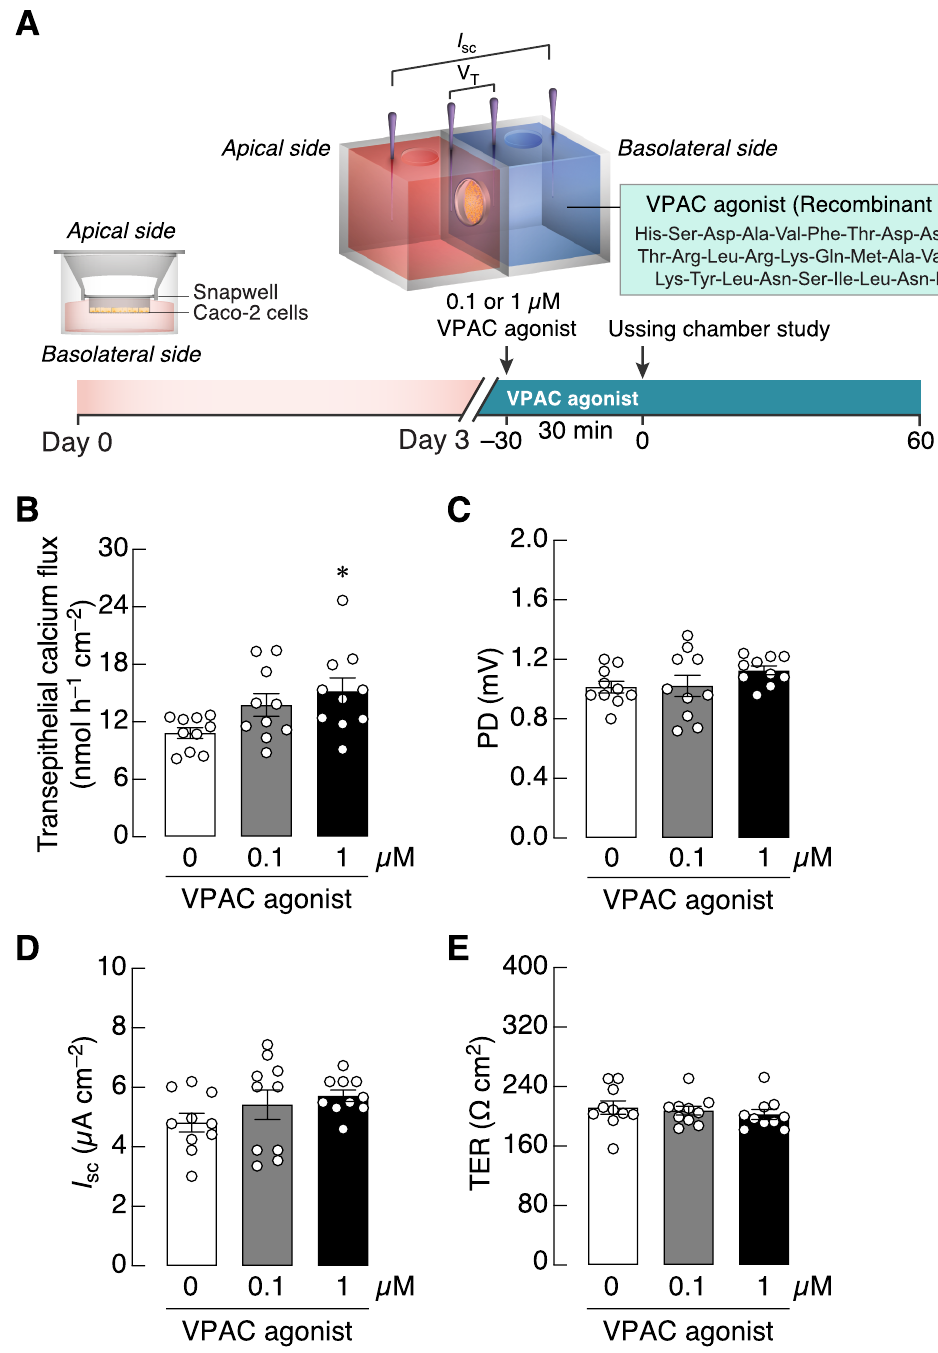
Fig 2. The effects of VIP/pituitary adenylate cyclase-activating polypeptide receptor (VPAC) agonist on intestinal epithelium-like Caco-2 monolayers. (A) Timeline of Experiment 1. (B) Transepithelial calcium flux and (C–E) epithelial electrical parameters (PD, I sc , and TER) across Caco-2 monolayers that were directly exposed to 0.1 and 1 μ M VPAC agonist on the basolateral side for 30 min. � p < 0.05 vs. control group (open bar, one-way ANOVA with Tukey’s multiple comparison